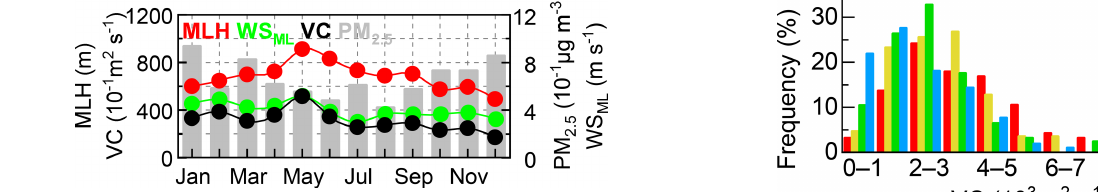
Figure 2. Frequency distribution of the daily VC from January 2016 to December 2017 in